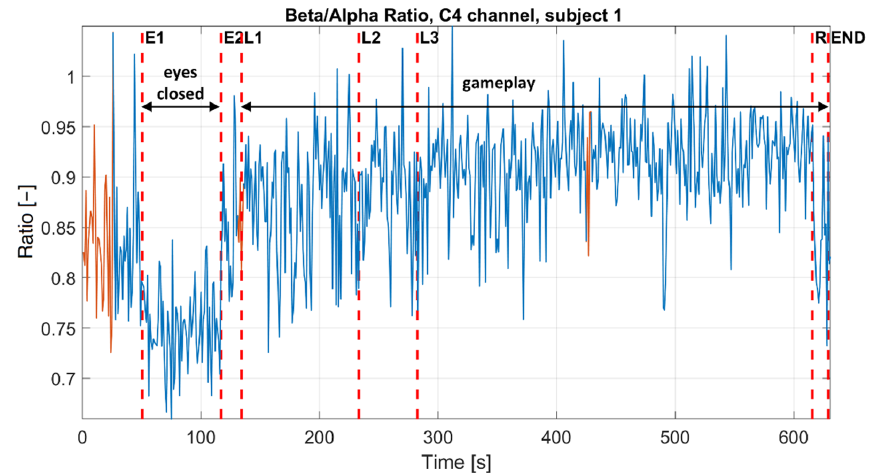
Figure 8. The beta/alpha ratio in the C4 channel of the subject 1.